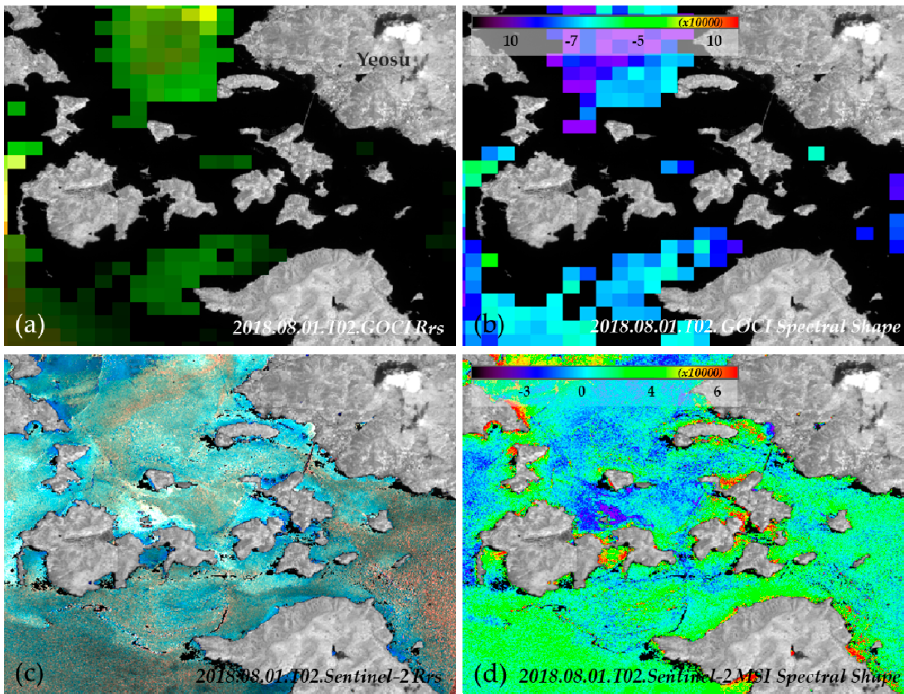
Figure 7. R rs true-color composite and Spectral Shape images collected with various sensors on 1 August 2018. ( a ) GOCI R rs true-color composite image (R: 680 nm; G: 555 nm; B: 490 nm), ( b ) GOCI Spectral Shape image, ( c ) Landsat OLI R rs true-color composite image (R: 680 nm; G: 561 nm; B: 483 nm), ( d ) Landsat OLI Spectral Shape image.